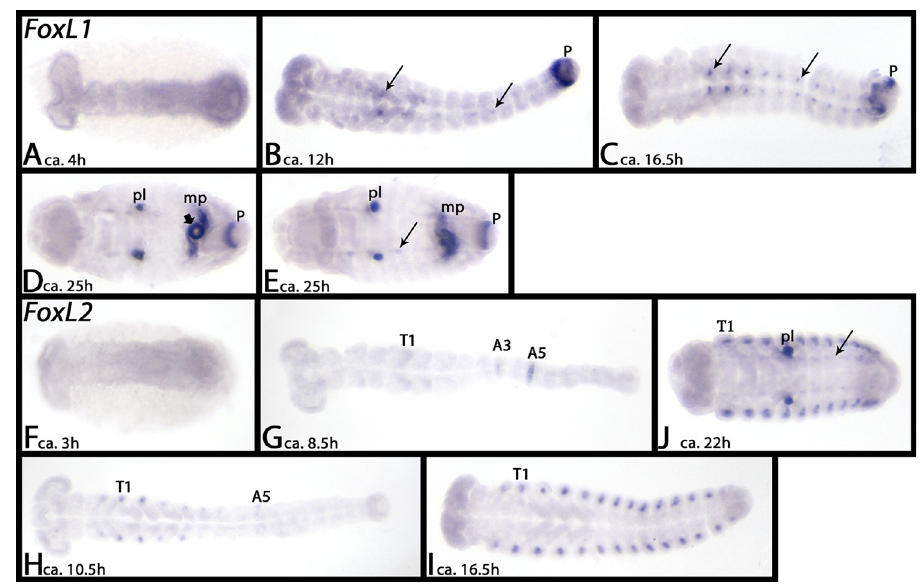
Fig 15. Expression of Tribolium FoxL1 (A-E) and FoxL2 (F-J). In all panels, anterior is to the left, ventral view. Embryos are flat-mounted, except embryos shown in panels A and F. Arrows in panels B, C, E and J point to expression in the VNS. Short arrow in panel D marks a ring of expression at the base of the Malpighian tubules. Note the unspecific staining of the pleuropodia in panels D, E, and J. Abbreviations in Table 2.